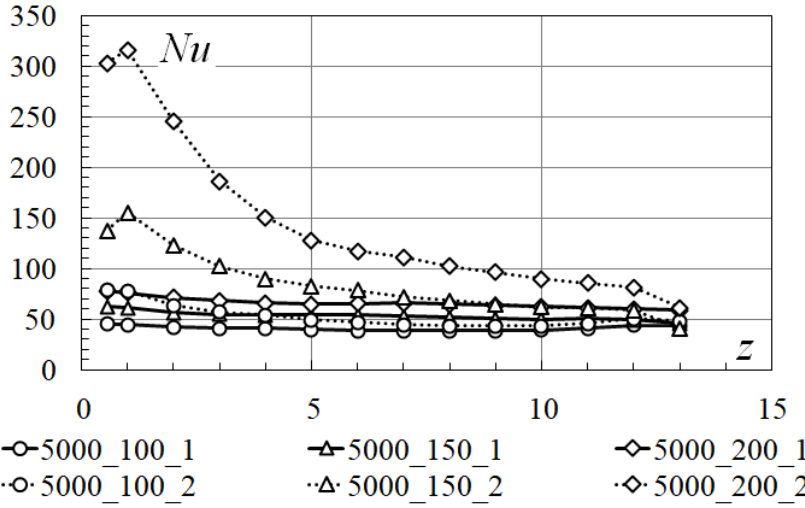
Figure 12. Changing the Nusselt numbers along the length of the duct z [m] 𝑞 (cid:2868) − 𝐶𝑜𝑛𝑠𝑡; 𝐺 − 𝑉𝑎𝑟𝑖𝑎 .